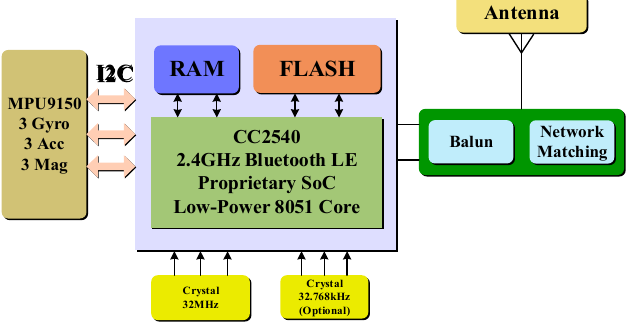
Figure 3. System hardware platform.